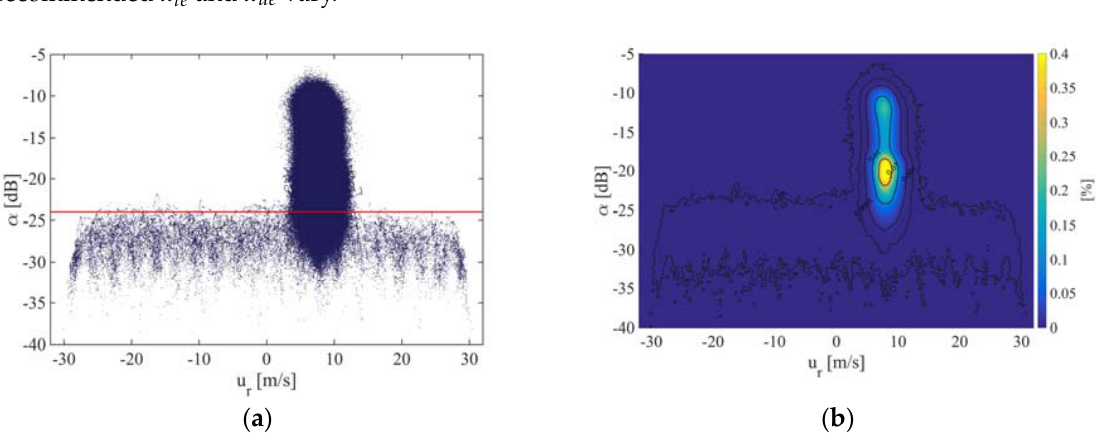
Figure 1. Example of a staring mode LiDAR measurement in the u r - α diagram for a duration of 30 min in distances in the range of 361 m to 2911 m. ( a ) Blue points represent single measurements points, the red horizontal line indicates the lower CNR-threshold of − 24 dB. ( b ) Visualisation of data density of measurement point distribution. Colours indicate different values of frequency distribution.